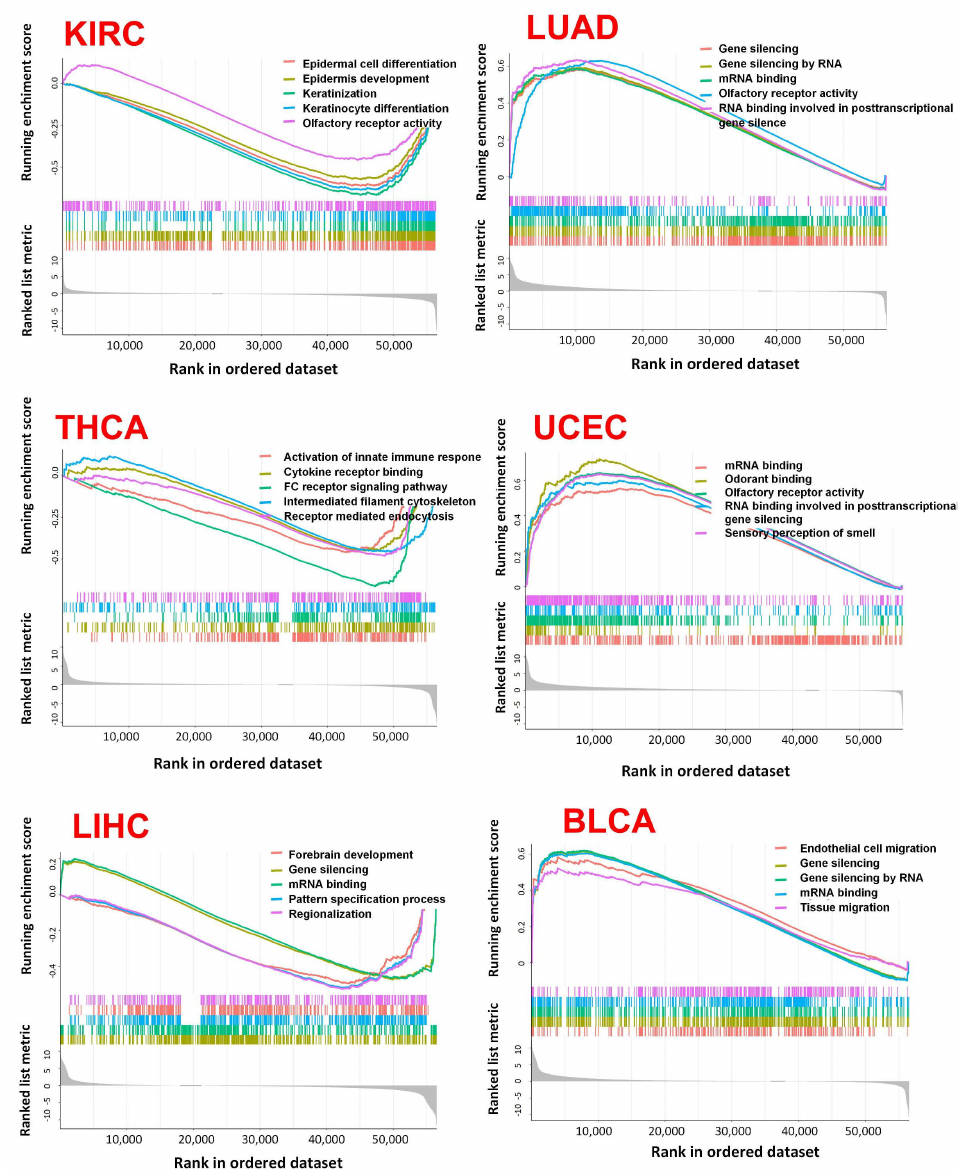
Figure 11. GSEA analysis in six types of cancers. GO functional annotation of the ABCG2 gene in different cancers were displayed. Differently colored curves indicate that the ABCG2 gene regulates different functions or pathways in different cancers. Peaks of curves upward indicate positive regulation and peaks of curves downward represents negative